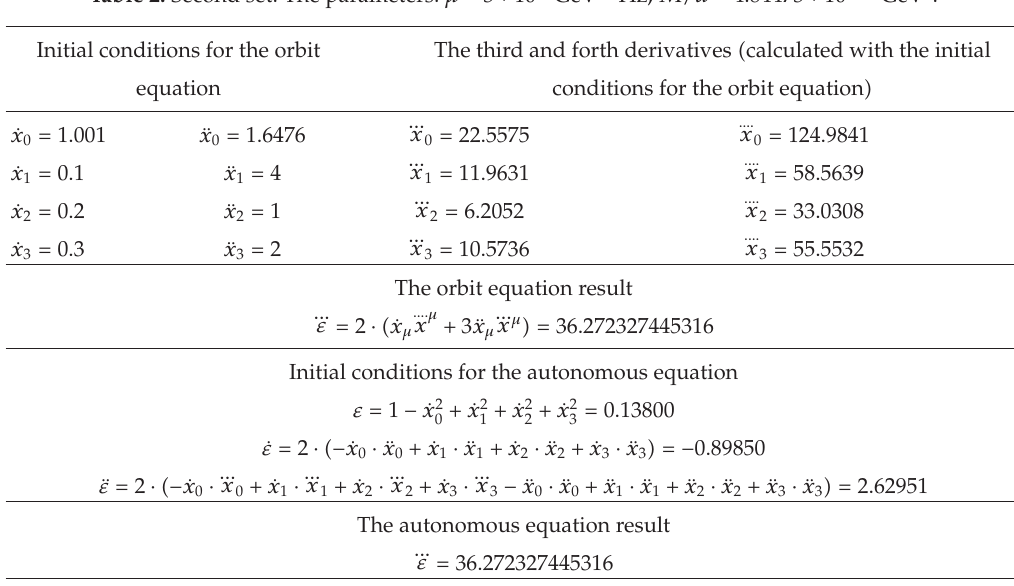
Table 2: Second set. The parameters: μ (cid:3) 3 ∗ 10 5 GeV − 1 Hz, M/α (cid:3) 4 . 84473 ∗ 10 − 10 GeV 2